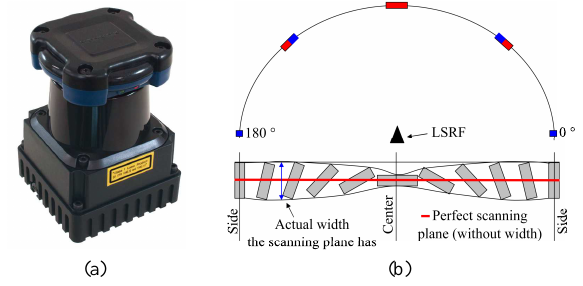
Figure 3: (a) Laser scanning range finder Hokuyo UTM-30LX- EW (Hokuyo, 2014a). (b) Schematic representation of the laser beam footprint (specified by manufacturer); the figure shows the effect of a rotating elliptical laser beam profile (Hokuyo, 2014b).